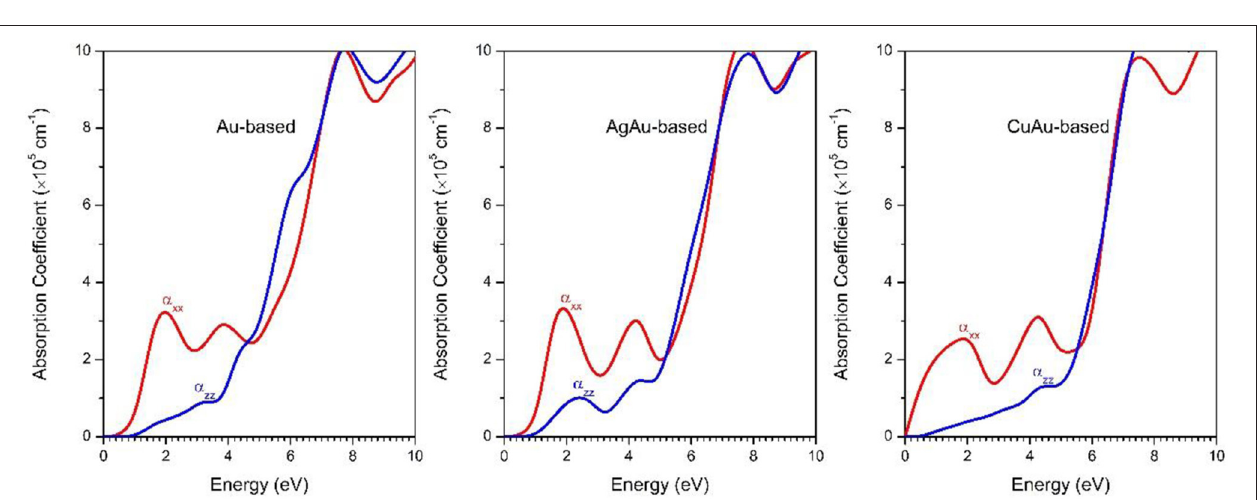
FIGURE 3 | The HSE optical absorption coefficients of 1B-based perovskite solar cell absorbers.